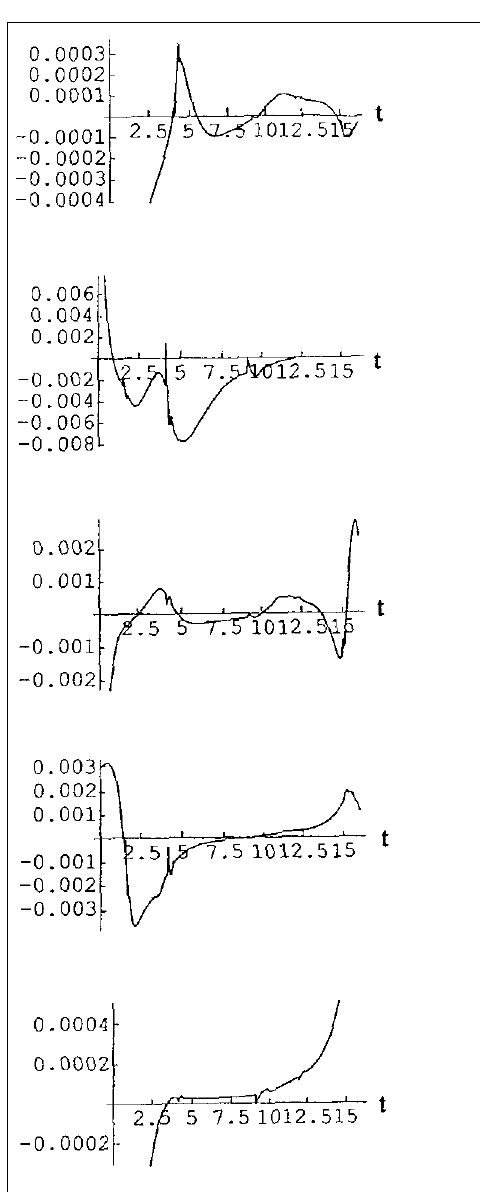
Fig. 2. Source intensities of electromagnetic radiation . field (cid:95) 2 (x,t) + (cid:95) (x,t) (cid:95) in the scale 10 22 [1/m 2 s 2 ]; for x in the scale [10 (cid:60) 5